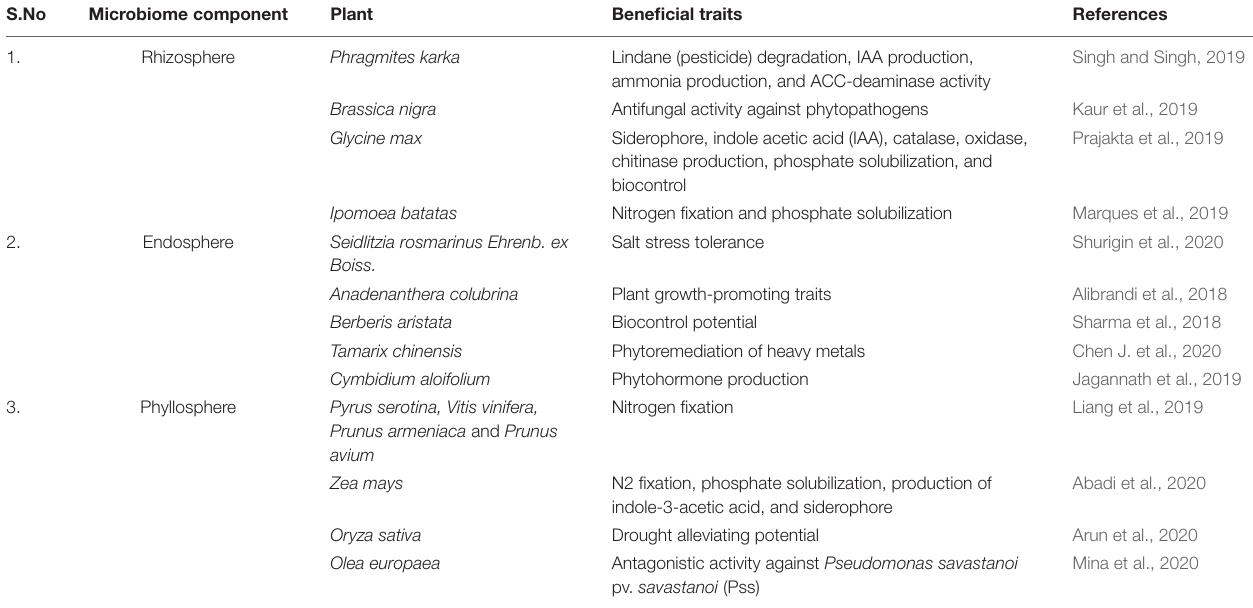
TABLE 1 | Beneficial traits conferred by microbial communities on host plant.